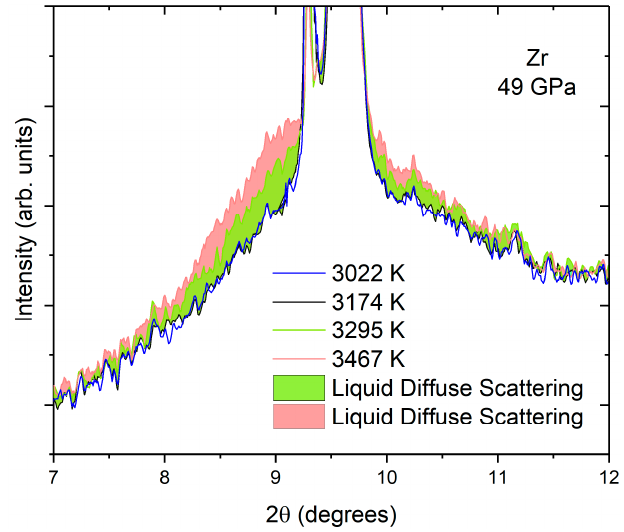
Figure 4. XRD patterns of a Zr sample in an LH ‐ DAC [37]. The liquid diffuse scattering appears at melting as a background signal that increases in intensity with temperature as the quantity of the liquid increases. The light green liquid diffuse scattering background corresponds to 3295 K, the pink one to 3467 K. The patterns at 3022 K and 3174 K correspond to solid Zr.